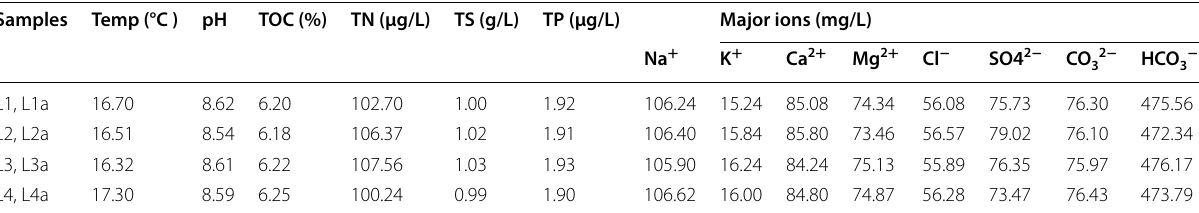
TOC total organic carbon, TN total nitrogen, TP total phosphorus, TS total salinity